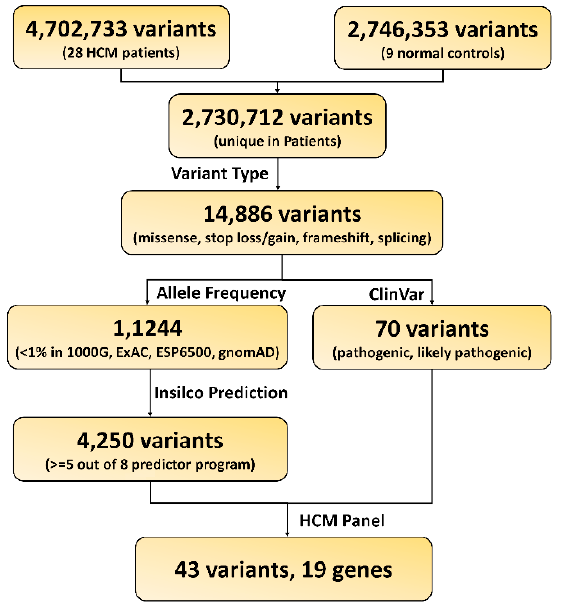
Figure 1. Workflow for functional variants and gene prioritization.